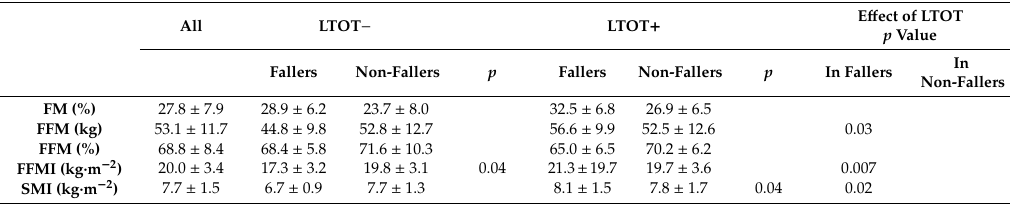
Table 2. Body composition measured by biphotonic absorptiometry in fallers and non-fallers grouped according to long-term oxygen therapy